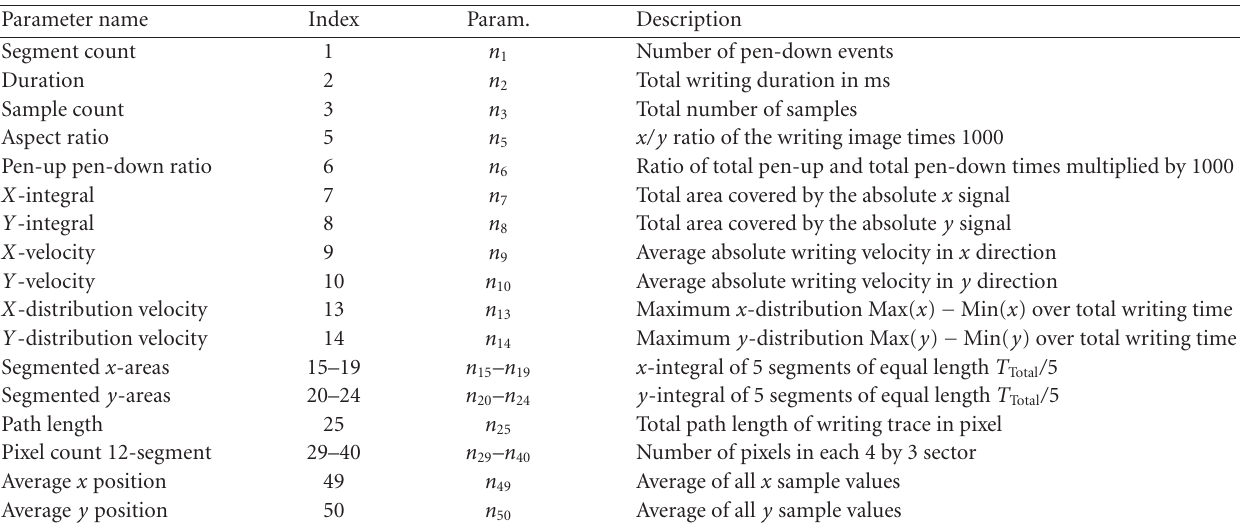
Table 7: Feature parameters evaluated from the extended test